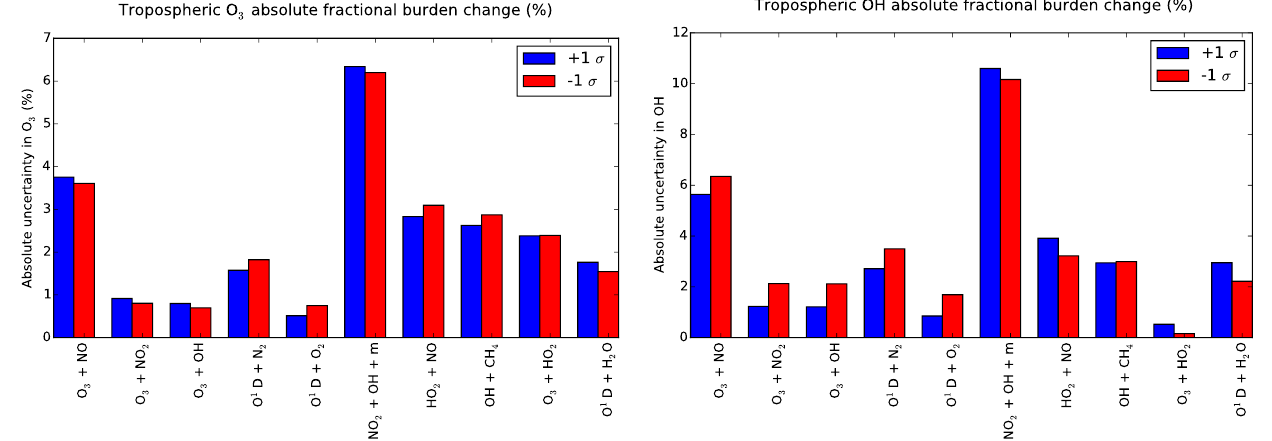
Figure 3. Uncertainty linearity: a comparison of absolute uncertainties in O 3 and OH tropospheric burdens for both positive and negative changes to the rate constants. These reactions show a similar magnitude of tropospheric species concentration change if the rate is set to its lower or higher sigma level of